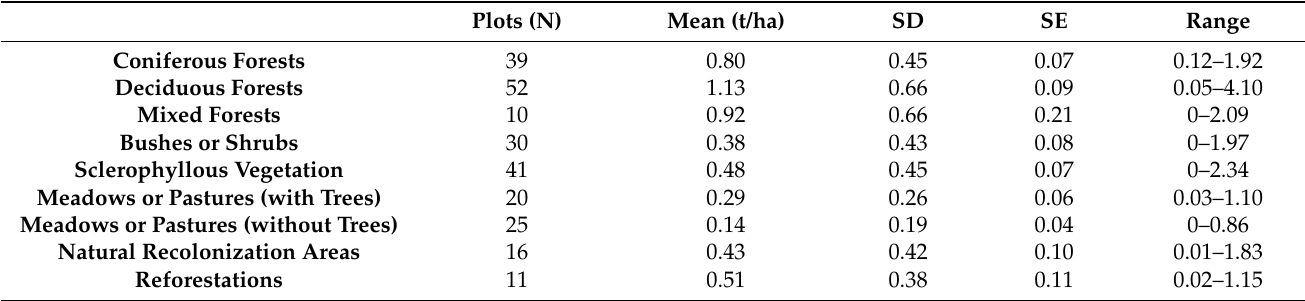
Table 2. 1-h fuel load statistics for land-cover